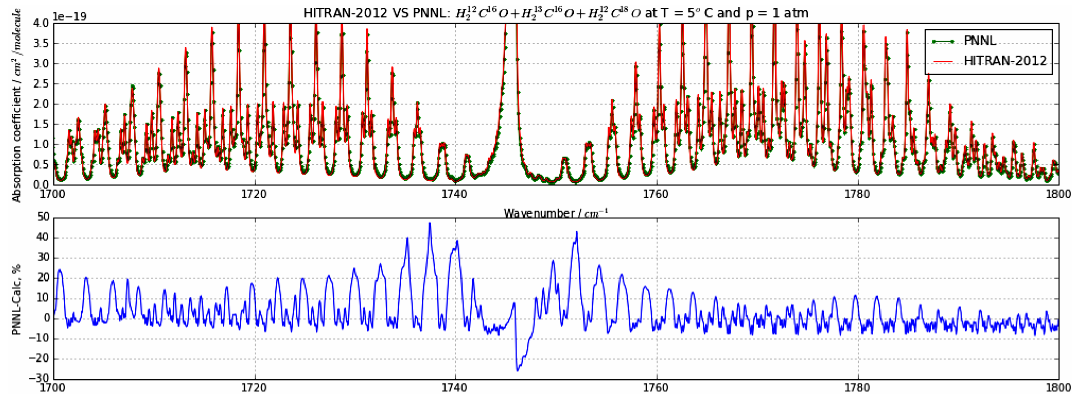
Figure 4. Residuals between calculated and experimental cross sections of H 2 CO in the 1700–1800cm − 1 spectral